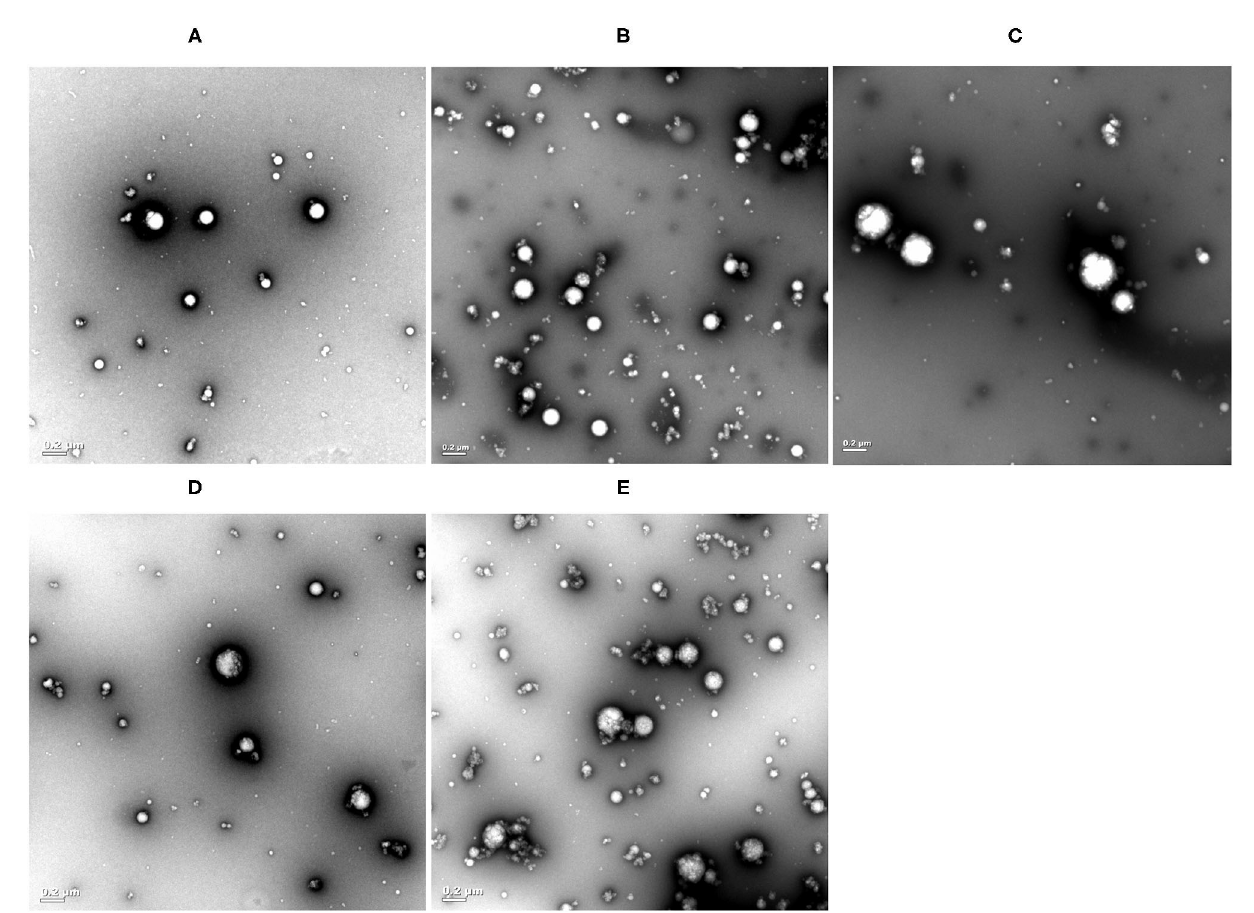
FIGURE 4 | TEM images of the emulsions with different SPI/BPC ratios, SPI/BPC = 1:0 (A) , SPI/BPC = 4:1 (B) , SPI/BPC = 2:1 (C) , SPI/BPC = 4:3 (D) , SPI/BPC = 1:1 (E) .